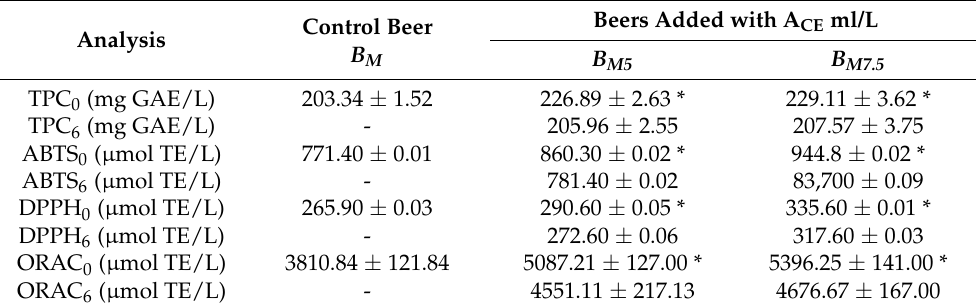
Table 2. TPC, ABTS, DPPH, and ORAC of control beers, with the addition of alcoholic concentrated extract (A CE ) at different concentrations (5 and 7.5